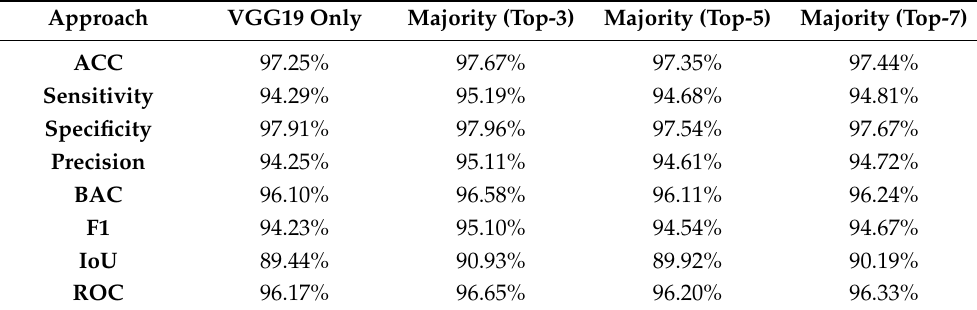
Table 6. The reported results concerning the “Monkeypox Skin Images Dataset” (MSID) from VGG19 and after applying the majority voting using k ∈ [ 3,5,7 ] .